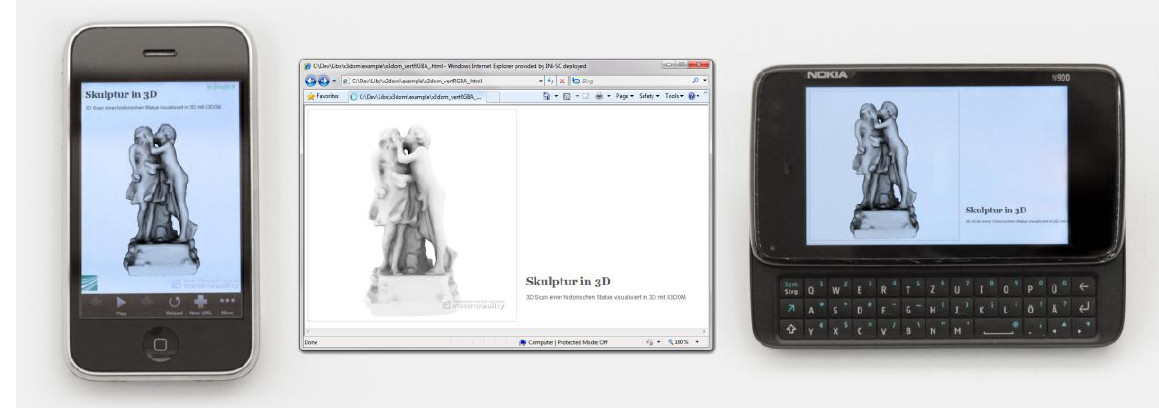
Figure 1. With MeshLab exported model of an old statue visualized via X3DOM in the same HTML page on 3 different